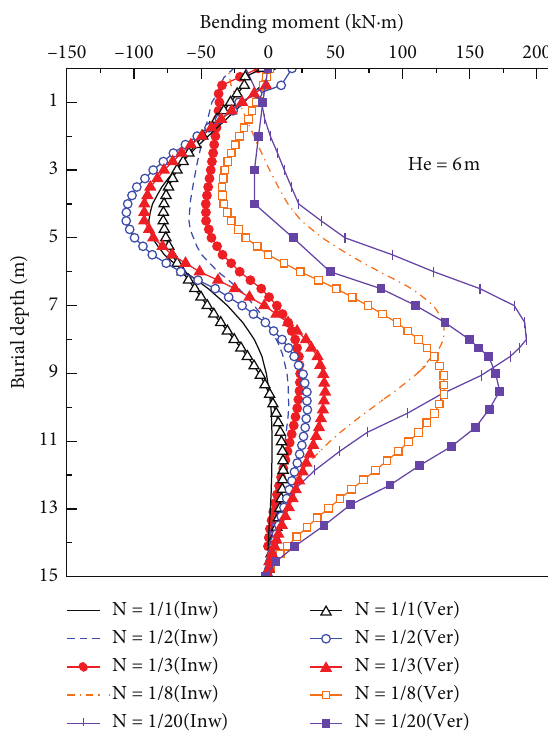
Figure 20: Comparison of bending moments of piles in VIIP with different N values.